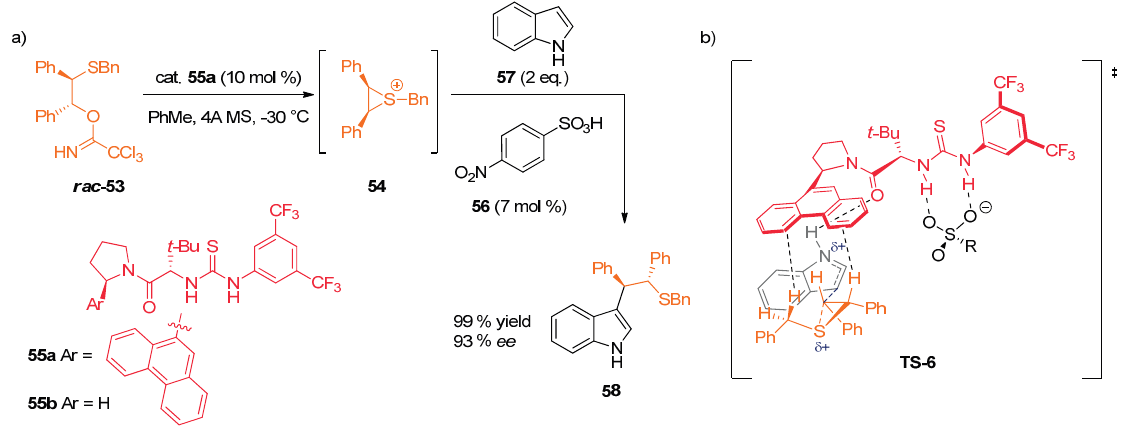
Figure 13. Thiourea-catalyzed ring opening of episulfonium ions ( a ); proposed transition structure model TS-6 , stabilized by attractive, non-covalent interactions ( b